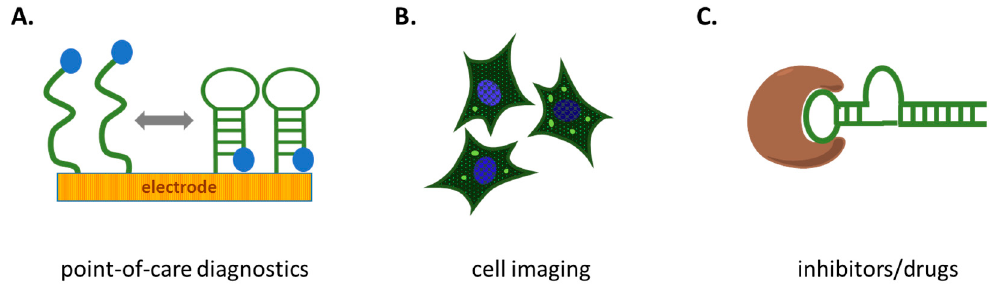
Figure 4. Conceptual figure highlighting potential applications of aptamers for DNA damage and repair. ( A ) Aptamers (green strands) could be incorporated into several platforms to create rapid analysis or point-of-care diagnostic kits to measured DNA lesion levels; ( B ) Aptamers combined with RNA tools such as “Spinach” could replace antibodies in cell imaging (allowing fluorescent imaging (bright dots) of damage/ repair proteins inside cells); ( C ) Highly specific aptamers (green strand) that inhibit repair proteins and polymerases (brown shape) could be used in cancer treatment and gene therapy.